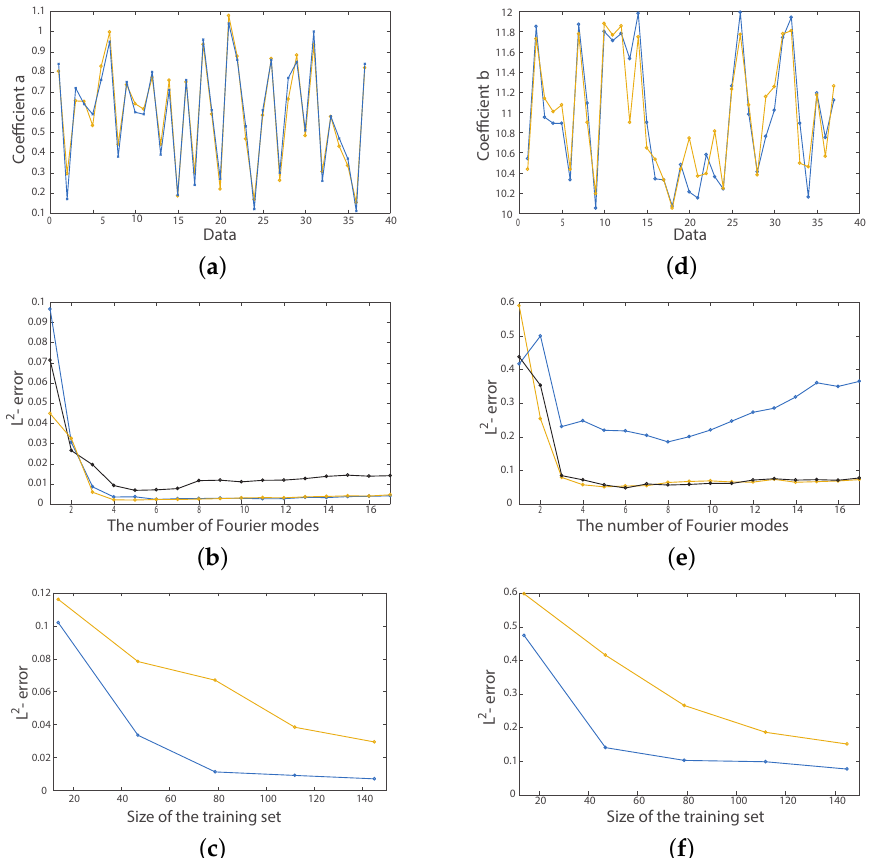
Figure 9. ( a ) Plot of actual (blue) vs. predicted (yellow) values of a 1 found by the GBR. ( b ) Accuracy of the parameter a 1 value on a test set vs. the number of first Fourier coefficients used (blue: h , black: 1/ ( h 2 − 1 ) , yellow: both). ( c ) Learning curve: the accuracy of the parameter a 1 vs. the size of the training dataset (yellow: 961 grid values, blue: first 6 Fourier coefficients). ( d ) Plot of actual (blue) vs. predicted (yellow) values of b found by the GBR. ( e ) Accuracy of parameter b on a test set vs. the number of first Fourier coefficients used (blue: h , black: 1/ ( h 2 − 1 ) , yellow: both). ( f ) Learning curve: the accuracy of the parameter b vs. the size of the training dataset (yellow: 961 grid values, blue: first 6 Fourier